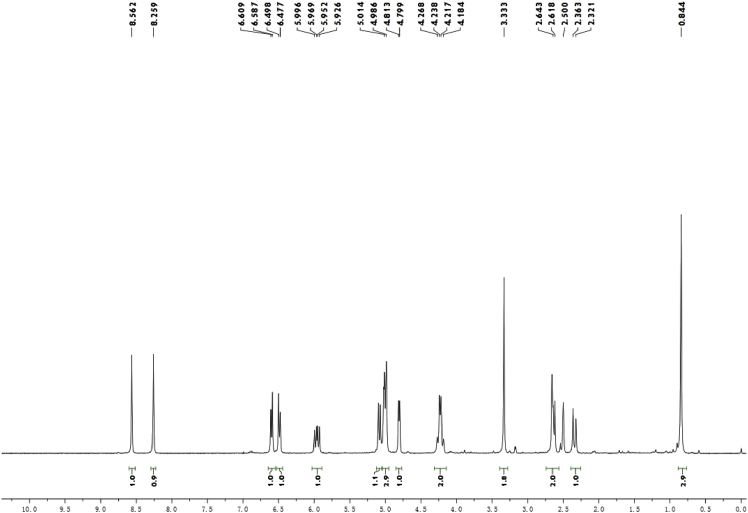
1H-NMR spectrum of meroterpenoid 6.